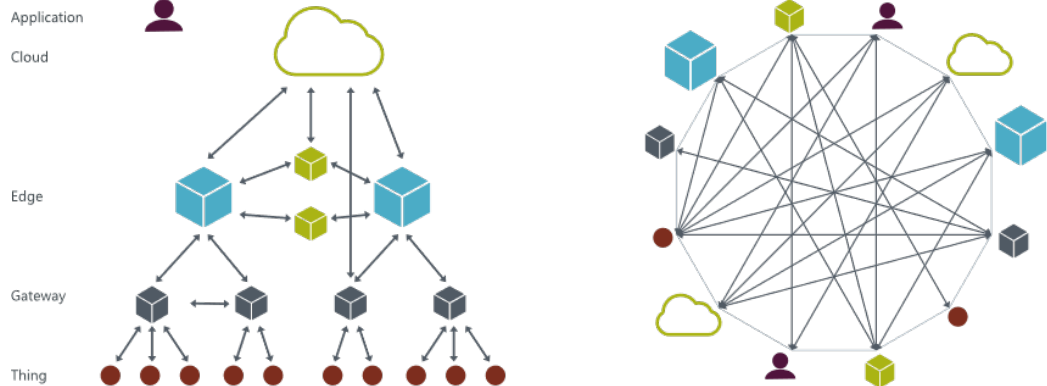
Figure 2. Conventional cloud/edge architecture and Coaty architecture (Source: [31]).